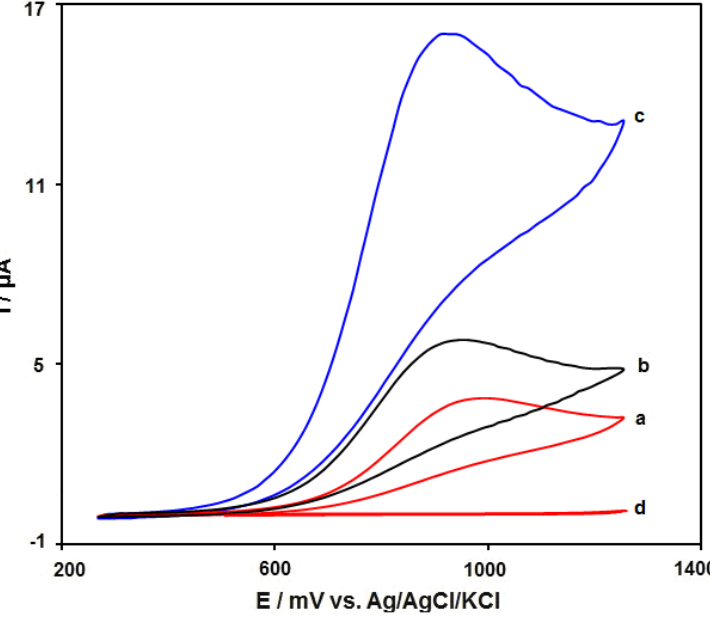
Figure 6. Cyclic voltammograms captured for ( a ) bare CPE, ( b ) MnO 2 NR/CPE and ( c ) MnO 2 NR- IL/CPE in PBS (0.1 M) at the optimized pH value of 7.0 under exposure to 50.0 μ M of SAA at a scan rate of 50 mV/s. Additionally, ( d ) as ( c ) in the absence of SAA.